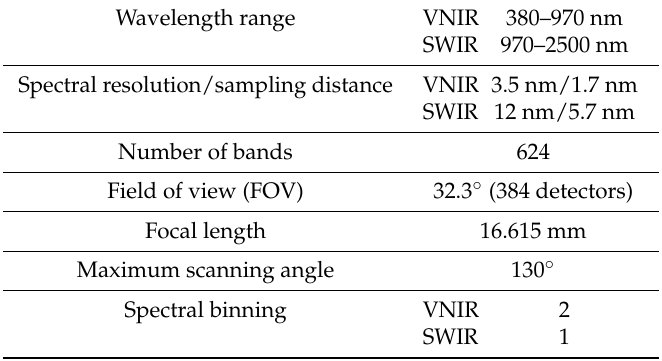
Table 2. Sensor specifications of the Specim AisaFenix VNIR–SWIR hyperspectral camera as given by Specim Spectral Imaging Oy, Oulu,